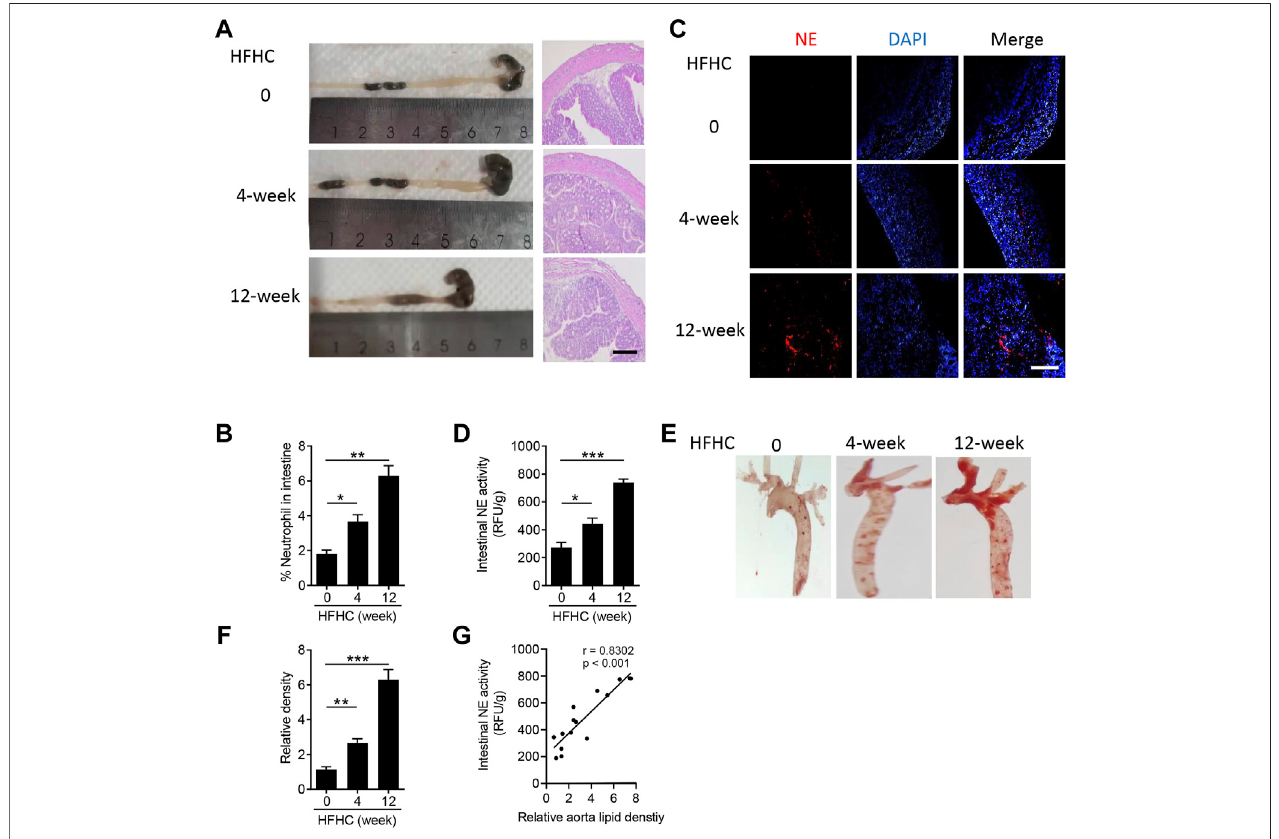
FIGURE 1 | Neutrophils in fi ltrate into the intestine during the atherosclerotic process. Male Apo E -/- mice were fed with high-fat high-cholesterol diet (HFHC) for 4 and12 weeks,andApoE -/- micewerefedwithnormaldietasthecontrolgroup. (A) Representativeimagesofthemousecolon(leftpanel)andhematoxylin-eosinstaining of the colon structure (right panel). Scale bar = 100 μ m. (B) Flow cytometry analysis of the percentage of Cd11b + Ly6G + neutrophils in the intestine. (C) Immuno fl uorescence staining of neutrophil elastase (NE, red color, neutrophil marker), and the nuclei were stained with DAPI (blue color). Scale bar = 100 μ m. (D) Measurement of the neutrophil elastase (NE) activity in intestinal lysates. (E,F) Oil Red O staining of the en face aorta (E) and the quantitative analysis of the relative lipid density (F) . (G) Correlationofthe intestinal NE activity and aorta lipid density. Dataareshown asmean ±SEM.n =5mice/group,and * p < 0.05, ** p < 0.01, *** p <